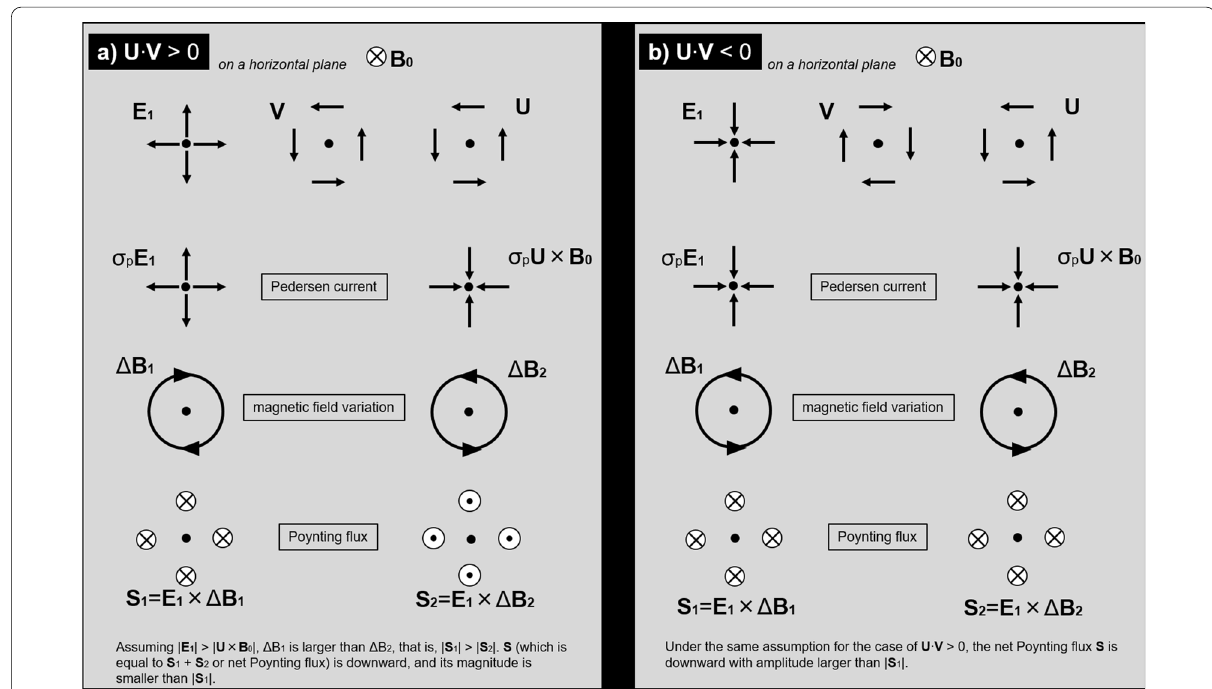
Fig. 5 A conceptual diagram of direction of the Poynting flux for the case of a positive and b negative U ∙